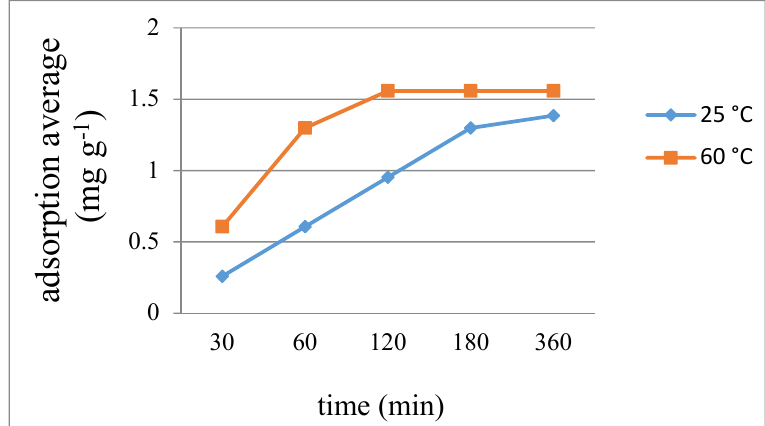
Figure 10. Average weight changes of complex 8 upon iodine adsorption.